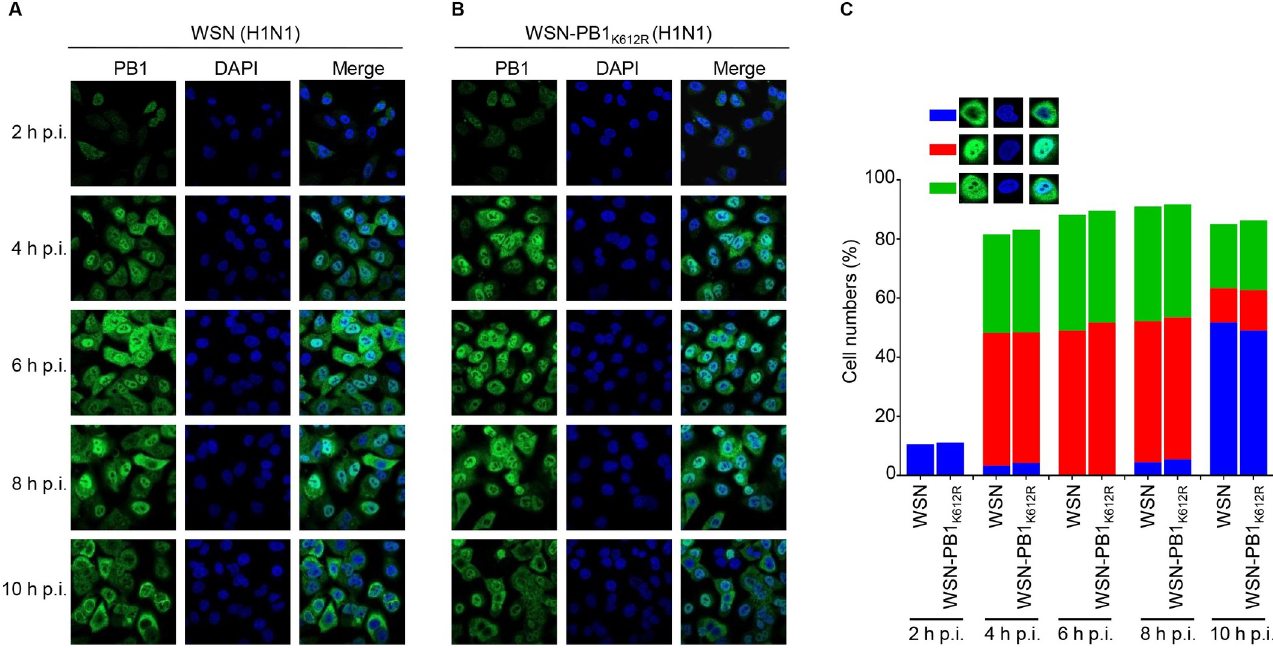
Fig 5. SUMOylation at K612 does not affect the cellular localization of PB1. (A, B) A549 cells were infected with WSN (H1N1) (A) or WSN-PB1 K612R (H1N1) (B) at an MOI of 5, and the cells were fixed at the indicated time points, followed by staining with a rabbit anti-PB1 pAb and incubation with Alexa Fluor 488 donkey anti-rabbit IgG (H+L). The nuclei were stained with DAPI. Representative images are shown. (C) Quantitative analysis of PB1 localization in virus- infected cells. The results shown are calculated from one hundred cells. On the basis of the confocal microscopy in panels A and B, the localization of PB1 was categorized into three types: predominantly cytoplasmic localization (blue), clear nuclear localization (red), and simultaneous localization in the cytoplasm and nucleus (green).